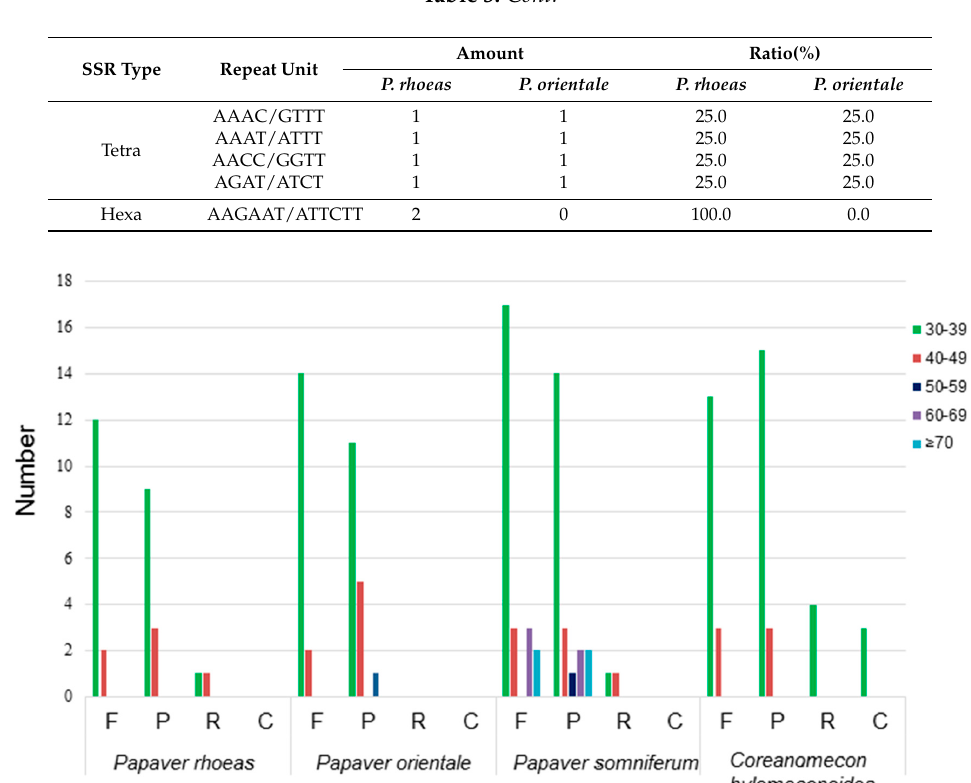
Figure 4. Repeat sequences in four chloroplast genomes. REPuter was used to identify repeat sequences with length ≥ 30 bp and sequence identified ≥ 90% in the chloroplast genomes. F, P, R, and C indicate the repeat types F (forward), P (palindrome), R (reverse), and C (complement), respectively. Repeats with different lengths are indicated in different colors.